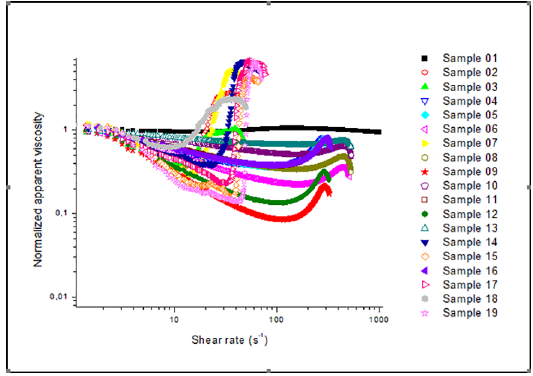
Figure 9. Normalized apparent viscosity as a function of shear rate.